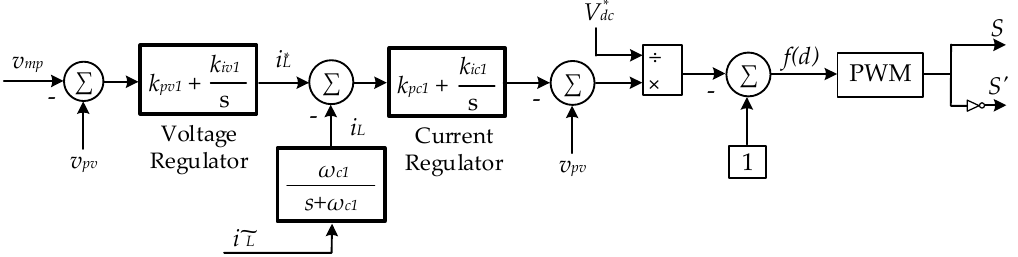
Figure 12. BDC control system when connected to PV.